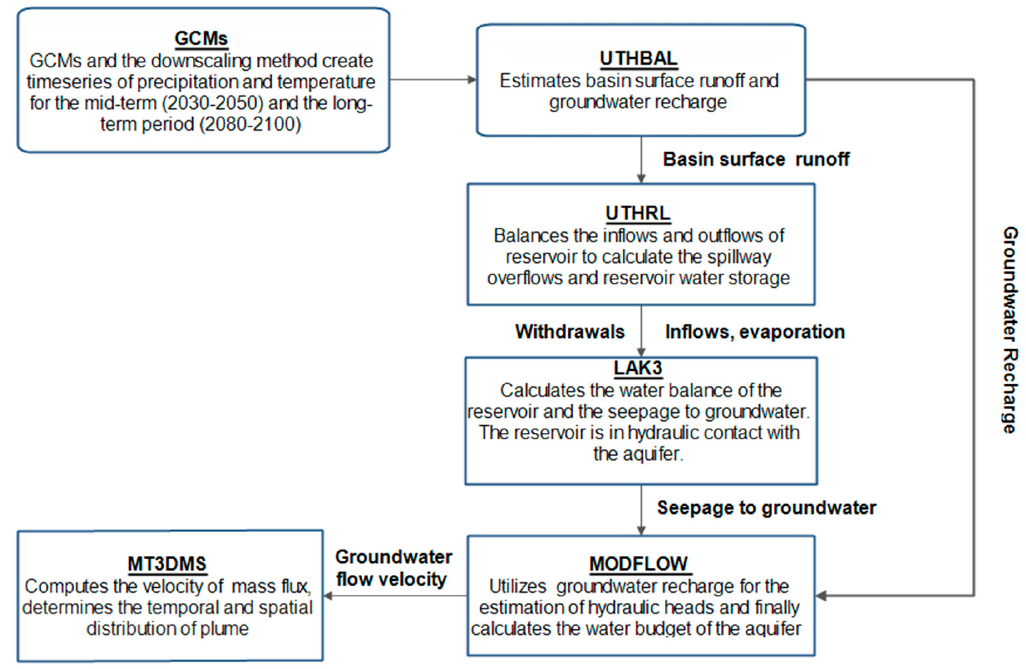
Figure 3. Flow chart of Modelling System Framework .